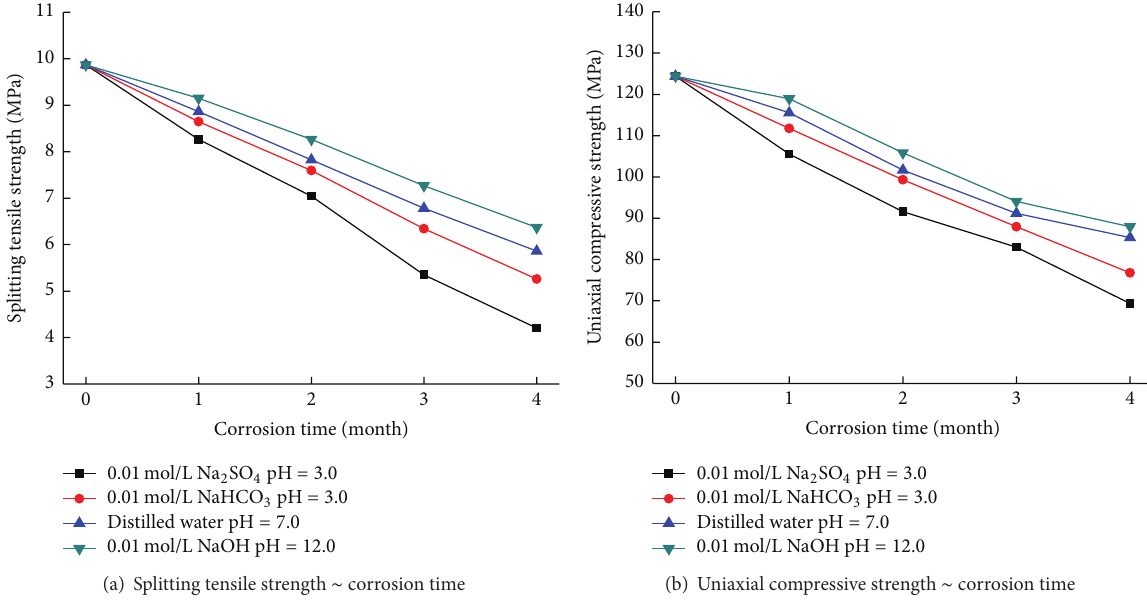
Figure 6: Relationships between the granite specimens’ splitting tensile strength and uniaxial compressive strength as well as the chemical corrosion time under different water chemical